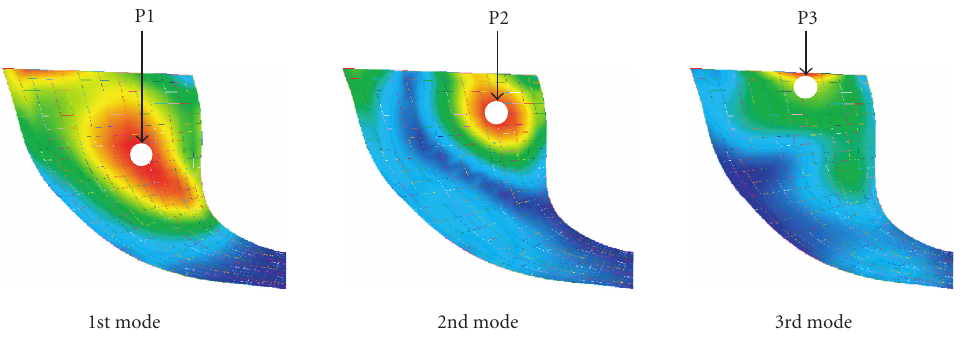
Figure 10: Locations of strain gauges (positions where the von Mises stress is the maximum for the three lowest blade bending modes).